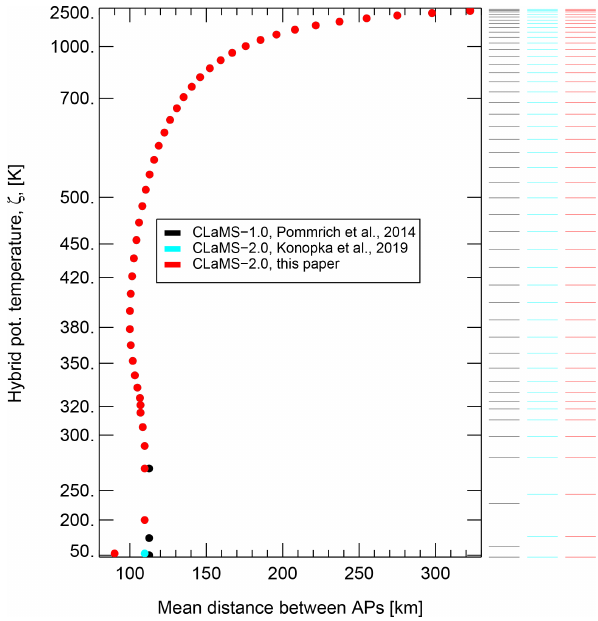
Figure A1. Initial distribution of APs with slightly enhanced thick- ness of the lowest layer (from ζ = 100 to 140K, i.e., from CLaMS 1.0 to CLaMS 2.0) and with slightly increased horizontal reso- lution in this layer used here ( r = 90km instead of r = 110km) for grid configuration generated with r 0 = 100km and aspect ratio α = 250 at ζ = 380K following procedure described in Konopka et al. (2012). For the here used EI/E5 reanalyses, the zonal horizon- tal resolution varies between 111km at the Equator and 78km at 45 ◦ latitude. With the choice r = 90 in the lowest layer, we aim to better include the resolved tropical convective